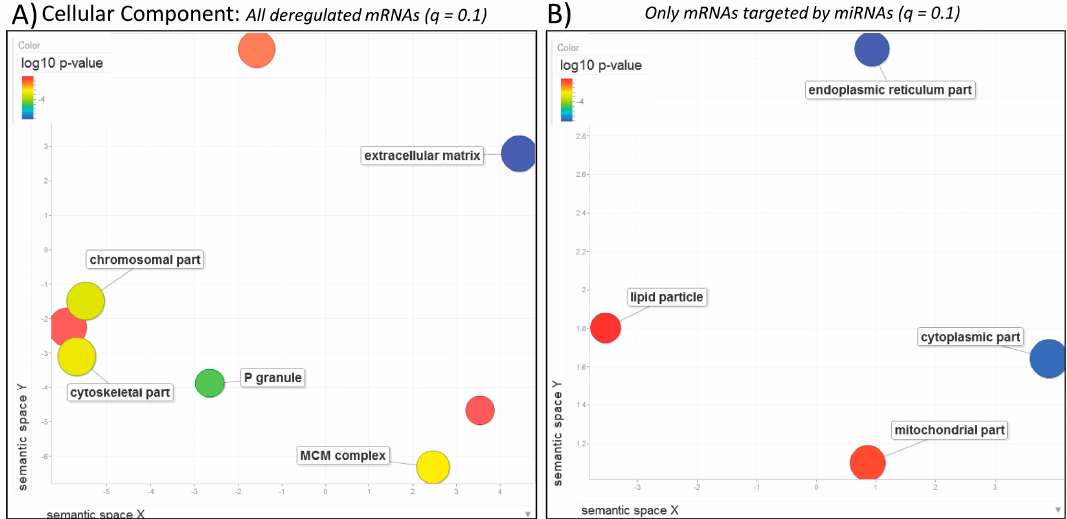
Figure 5. Cellular Component. REViGO plots showing categories in 2D space for ( A ) all deregulated mRNAs obtained from DESeq2 (q ≤ 0.1) and ( B ) mRNAs that are predicted targets of the miRNAs identified by miRNA ‐ Seq (q ≤ 0.1). Blue and green bubbles are GO terms with more significant p ‐ values than the orange and red bubbles, i.e., extracellular matrix and endoplasmic reticulum part. Closeness on the plot reflects semantic similarities between GO terms. Bubbles of more general terms are larger. Only the most significant terms are labelled when space is an issue.